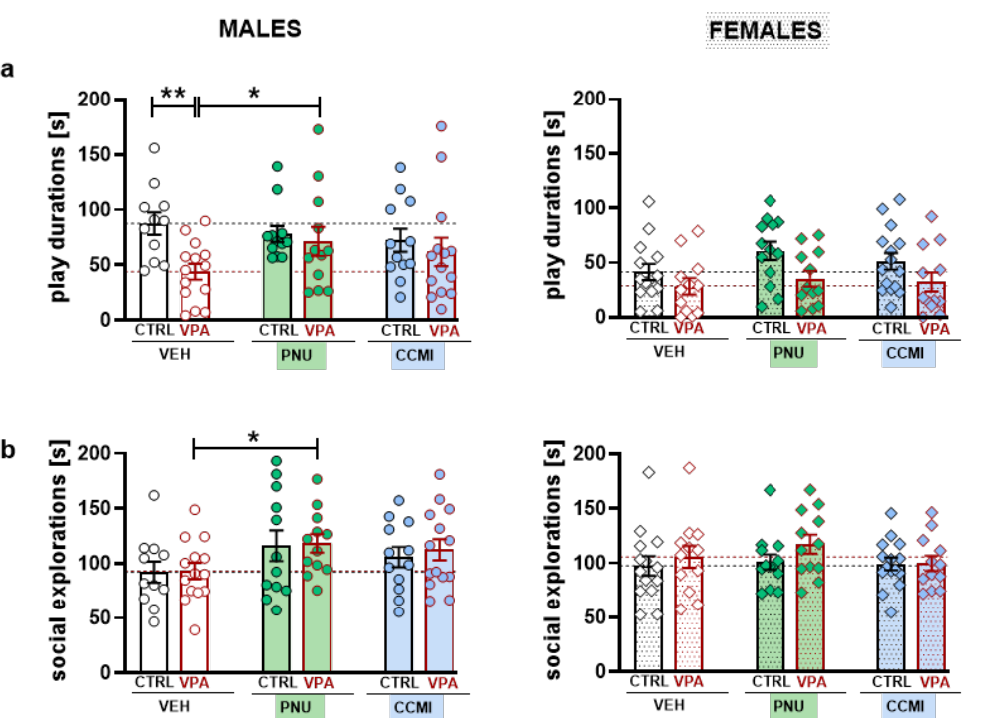
Figure 1. The effect of α 7–nAChR PAMs on social play behavior ( a ) and social exploration ( b ) in VPA and CTRL male and female rats. The tested compounds (or vehicle, VEH) were administered at a dose of 1 mg/kg 30 min prior to testing. Data are presented as a mean ± SEM of the time spent by a pair of rats on social play ( a ) and social explorations ( b ). The results were expressed as the summed score of both animals in a pair. Symbols: ** p < 0.01, * p < 0.05, planned comparisons.